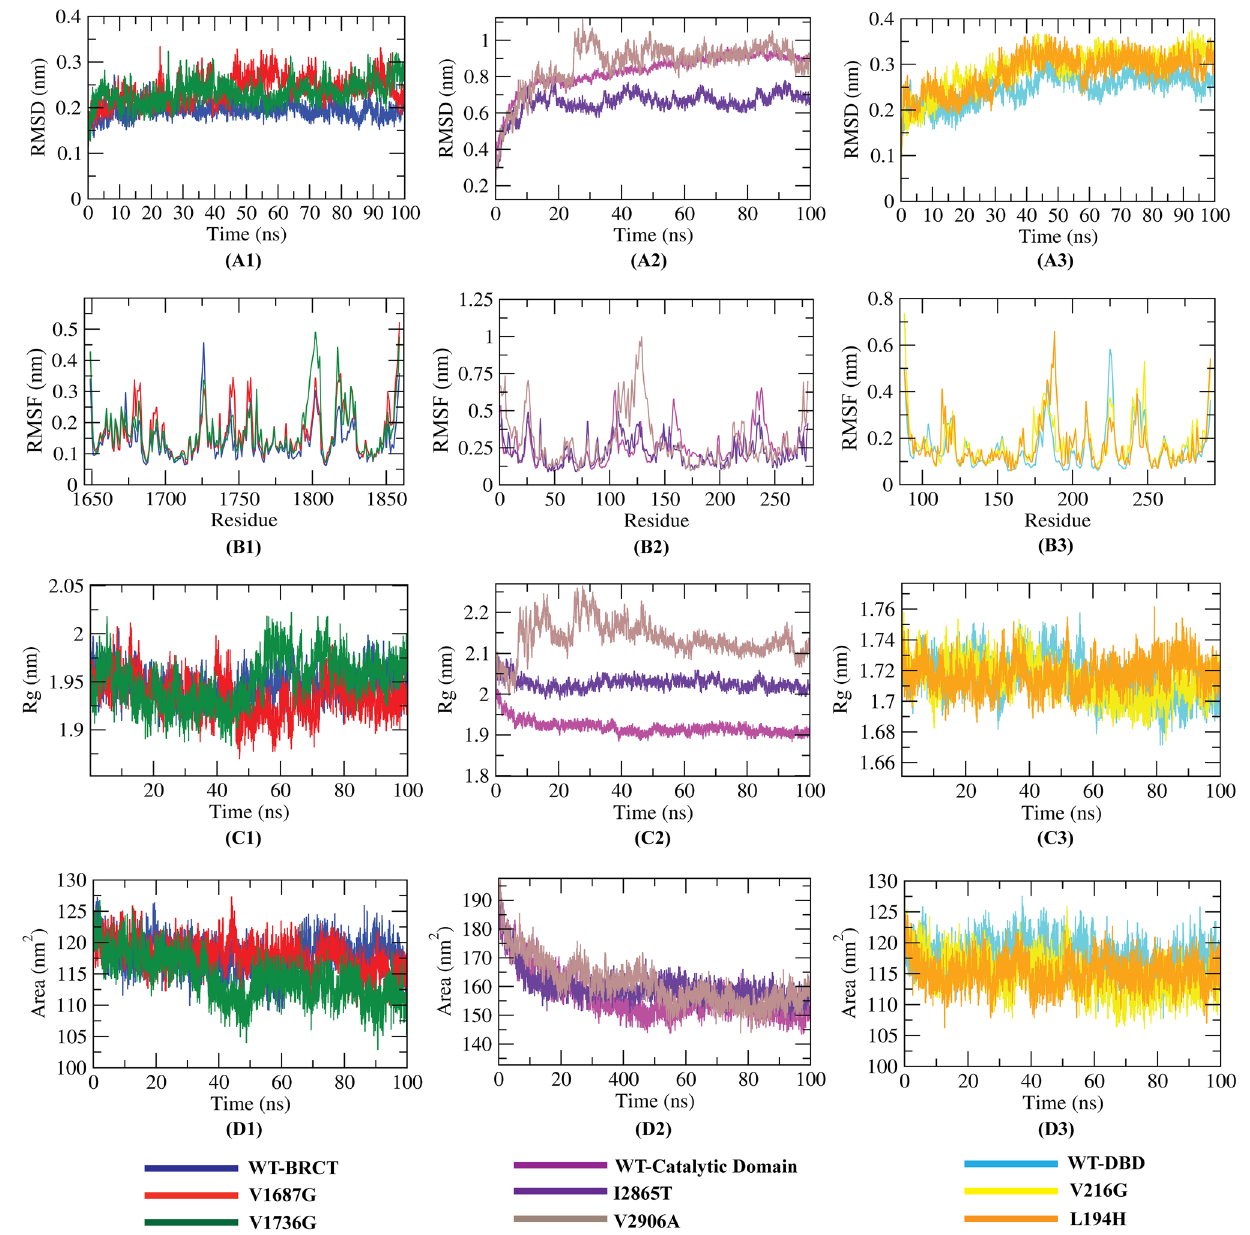
Figure 6. MD simulation results (1st independent run) of WT and mutant variants. ( A1–A3 ) RMSD analysis, ( B1–B3 ) RMSF analysis, ( C1–C3 ) radius of gyration (Rg) analysis, and ( D1–D3 ) SASA proteins with time is shown in Fig. 6D1–D3. Similar results were observed in case of the 2nd and 3rd MD runs with no significant deviation as seen from Table 7, Supplementary Figs. S3 and S4. Stability of the docked protein–ligand complexes. The stability of the docked complexes during simulation period were assessed analyzing RMSD of the protein backbone and ligand structure as well as the hydrogen bonds analysis formed by PK083 with the WT and mutants (Fig. 7). We performed 3 independent production runs of the protein–ligand complexes, the 1st production run included both the WT and mutant- PK083 complexes (Fig. 7) while the 2nd and 3rd production run included the mutant-PK083 complexes (Sup- plementary Figs. S5, S6). It was observed that, all the WT and mutant proteins exhibited similar backbone RMSD except the L194H mutant, the WT (L194) protein were more stable compared to the mutant. In case of the six mutants, it was found that rather than the V2906A complex, all the remaining protein–ligand complexes were stable. For the five stable complexes, the ligand RMSD was less than 0.1 nm indicating the initial ligand-backbone contacts remained intact during the simulation period. In case of V2906A, the PK083 showed multiple binding orienta- tions and it re-equilibrated several times during the 100 ns simulation (Fig. 7B3). It was also observed that the